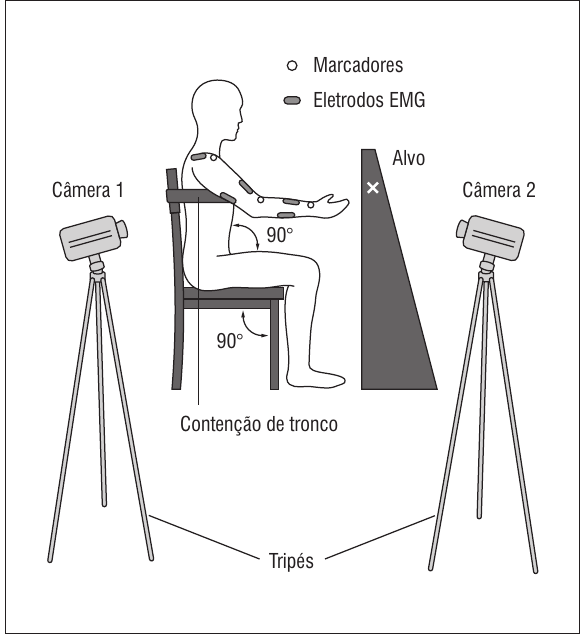
Figura 1 - Esquematização do ambiente de coleta